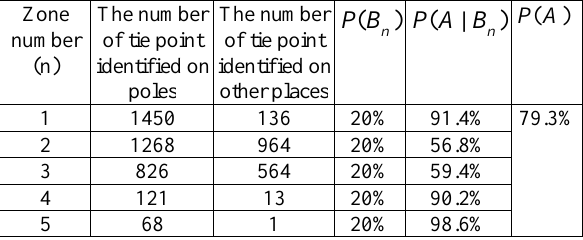
Table 3. Calculation results for the total probability of pole-like infrastructure detection.